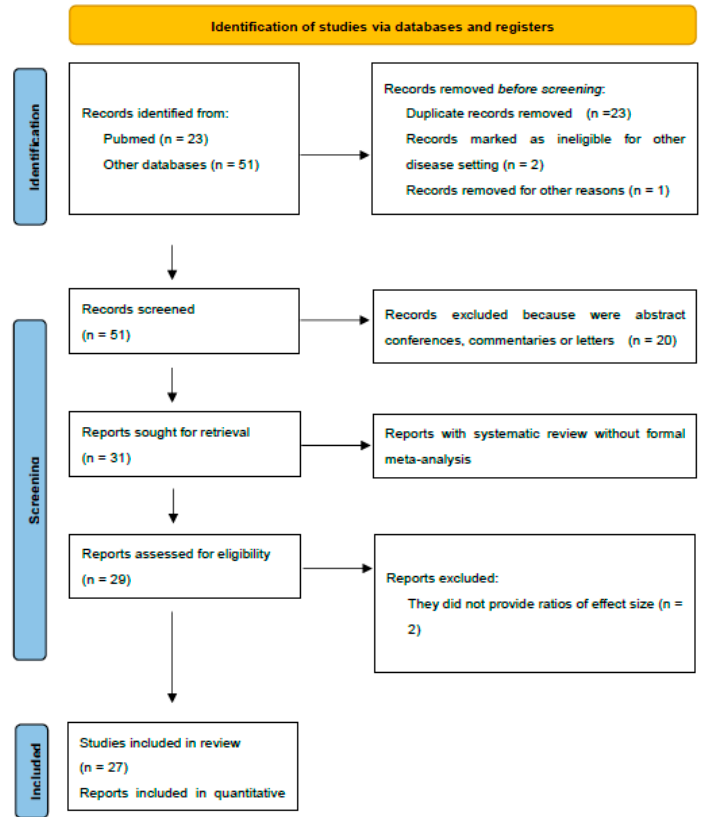
Figure 1. Flow diagram of the included studies. Table 1 describes the characteristics of the 27 eligible meta-analyses [7–33], which were published between 2021 and